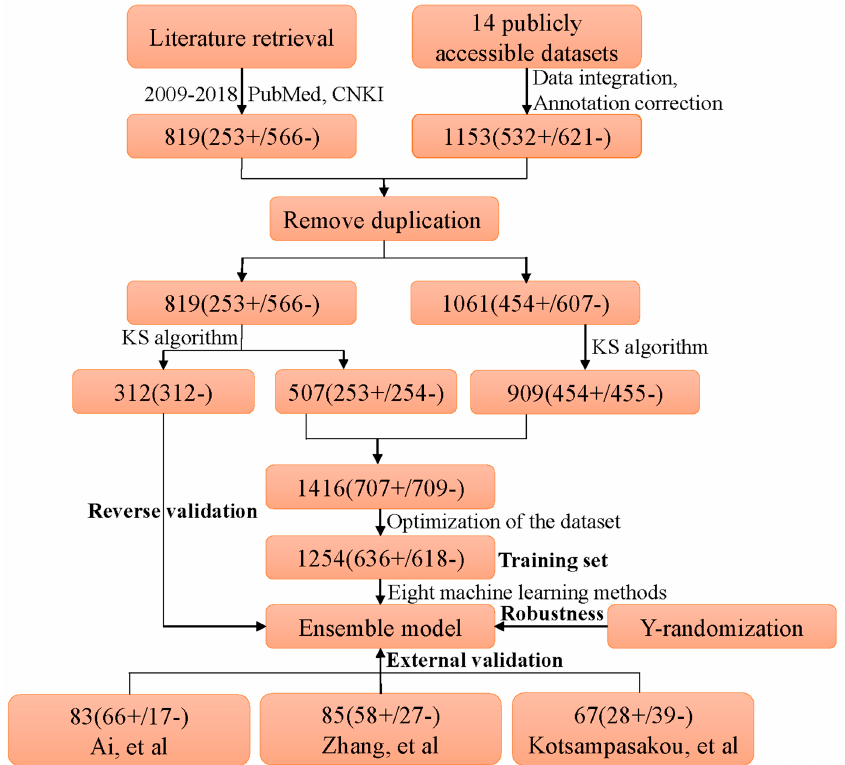
Figure 6. Diagram of data processing and model construction. KS algorithm: Kennard–Stone algorithm. “ + ” and “ − ” denote the number of DILI-positives and DILI-negatives, respectively.